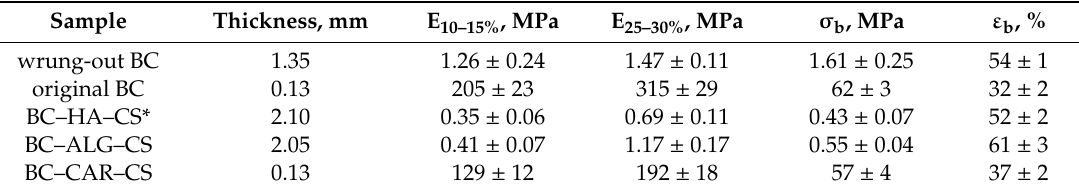
Table 4. The mechanical properties of bacterial cellulose composites.